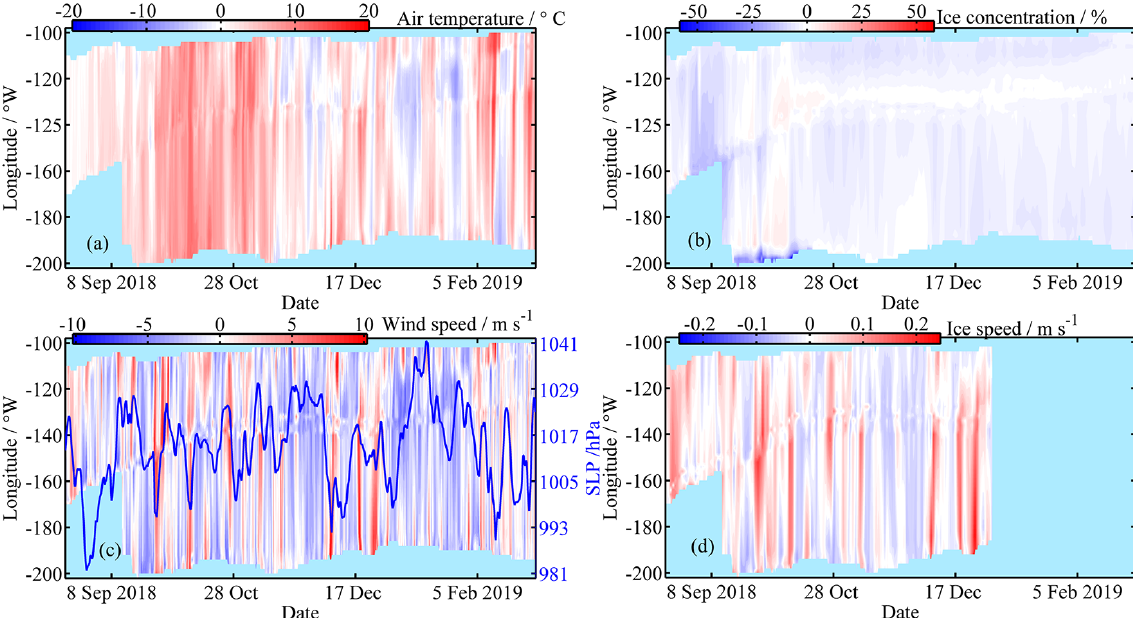
Figure 7. Same as Fig. 2, but for zonal changes. Longitudes with values below − 180 denote the eastern